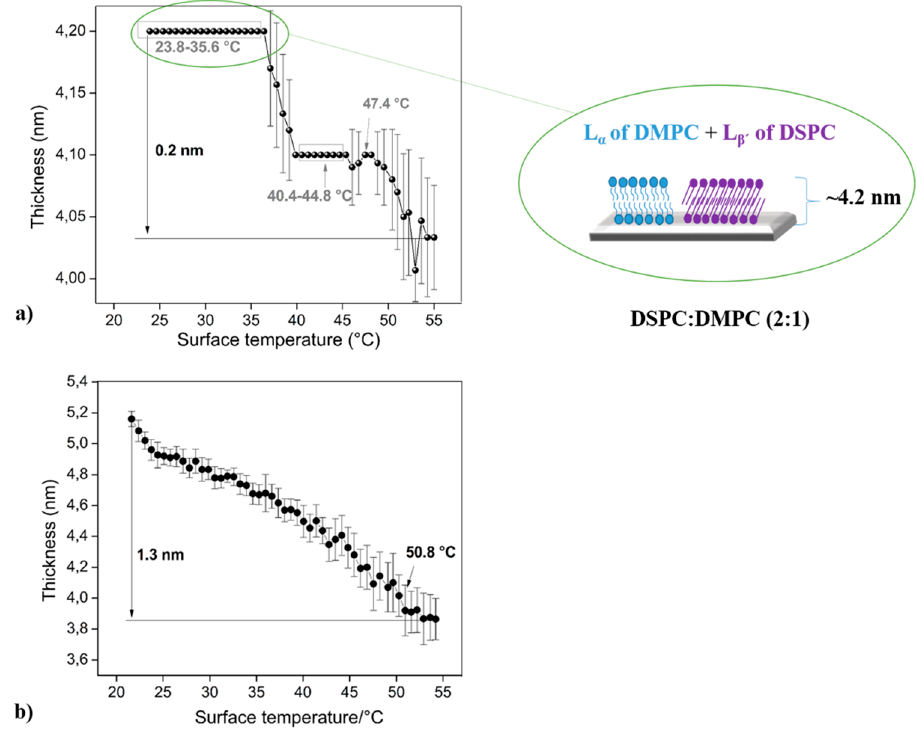
Figure 4. Thermal behavior detected for optical studies (ellipsometry) and a diagram of ( a ) DSPC:DMPC (2:1) and ( b ) DSPC:DOPC